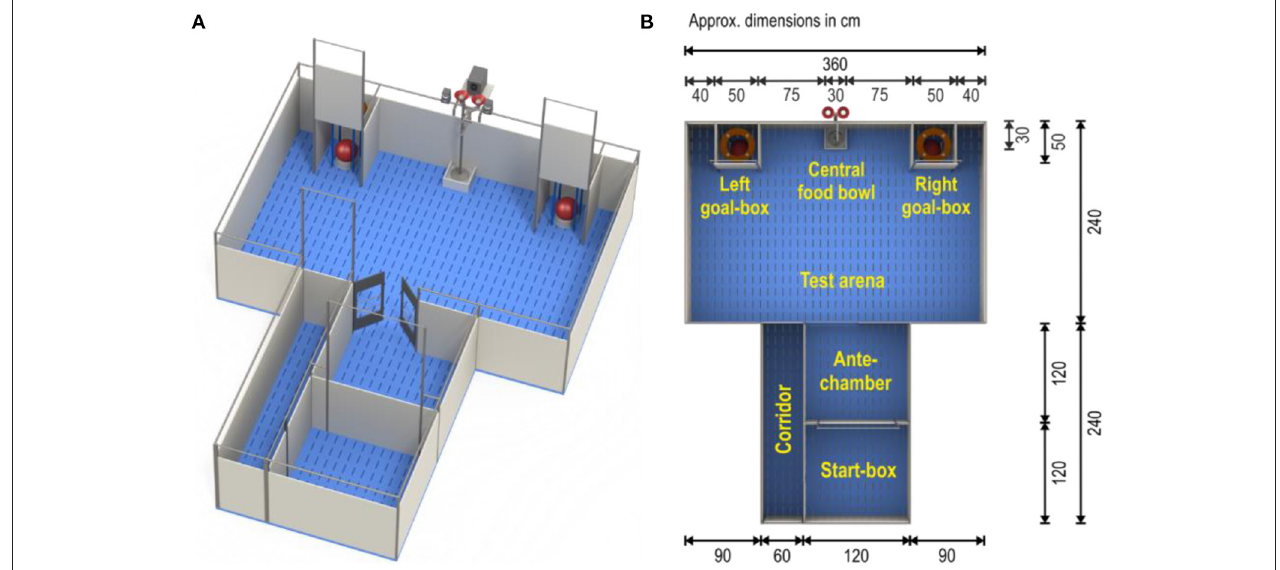
FIGURE 1 | Judgement bias test apparatus (A) and its dimensions (B) (Illustration by Yorrit van der Staay). Food bowls pictured are dog bowl “Road Refresher” (Prestige Pets, Essex, UK), Size Large, Color Gray. Diameter of bowl base: 242mm. Height of bowl: 102mm. The ball covering the bowl is the “Push ‘N Play” (Jolly Pets, Streetsboro OH, USA), size large (diameter 25cm); color red.